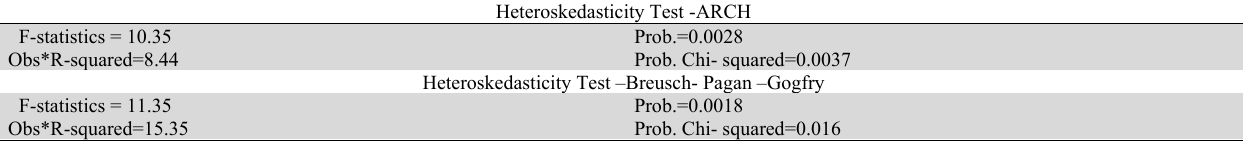
Heteroskedasticity Test.